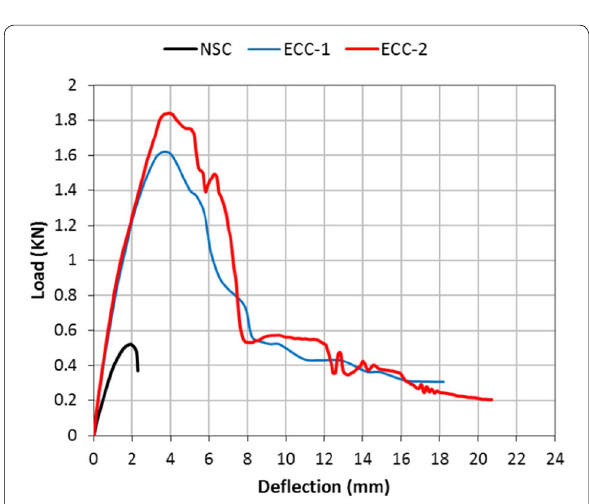
Fig. 6 Load–deflection curve due to